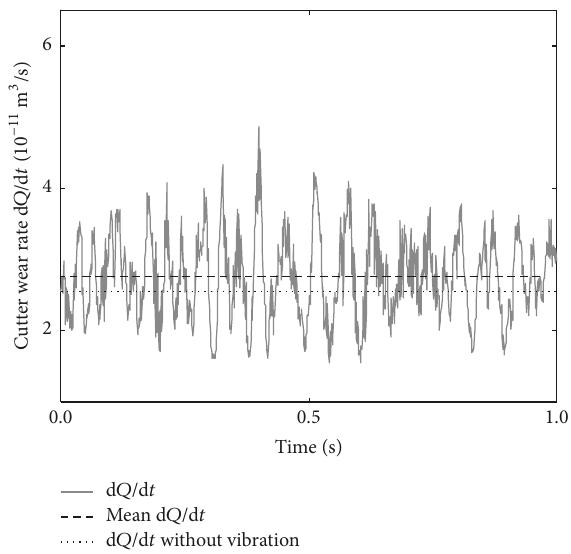
Figure 9: Cutter wear rate in soft rock tunneling for Ω 0 = 6 rpm and 𝑉 0 = 1.2 mm/s.